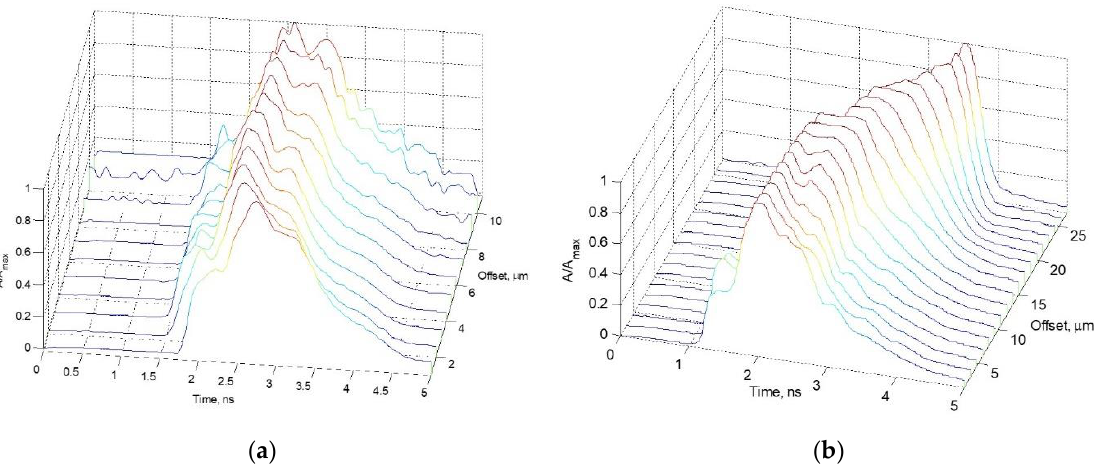
Figure 22. DMD map of combined link, containing 20 m length of chiral ESSR-MOF (Tx) and 500 m length of MMF Cat. OM2 (Rx): ( a ) 10 revolutions per meter; ( b ) 66 revolutions per meter.